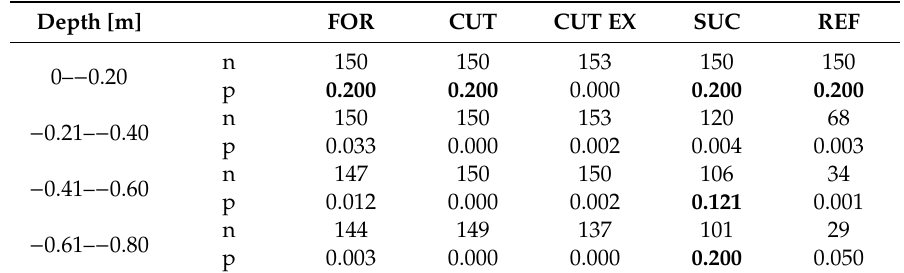
Table 14. Results of the Kolmogorov–Smirnov test for depth aggregated data. Normally distributed datasets ( p > 0.05) are indicated